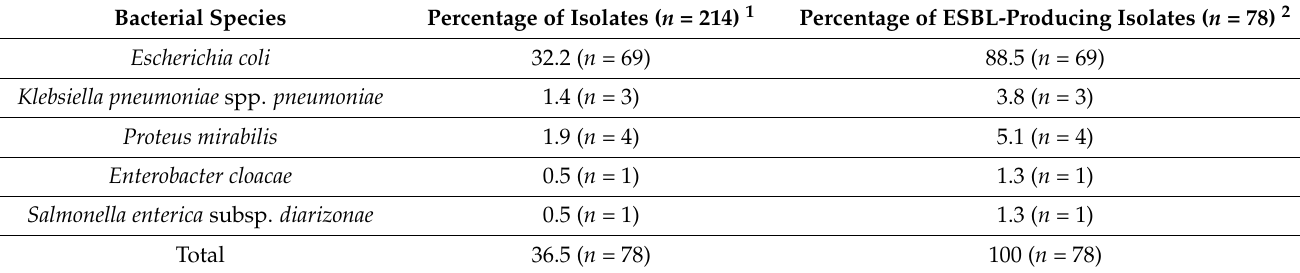
Table 3. Isolation and identification of ESBL-producing bacteria from pig